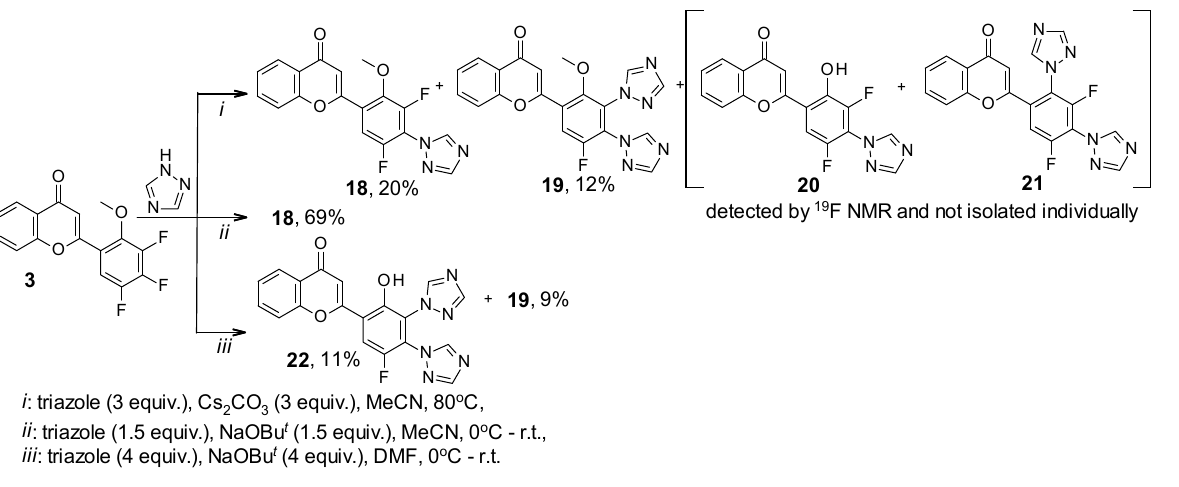
Scheme 5. Reaction of 2-(3,4,5-trifluoro-2-methoxyphenyl)-4 H -chromen-4-one 3 with 1 H -1,2,4-triazole. Table 4. 19 F NMR data of mixture of Cs 2 CO 3 -promoted reaction of flavone 3 and 1 H -1,2,4-triazole. Compound